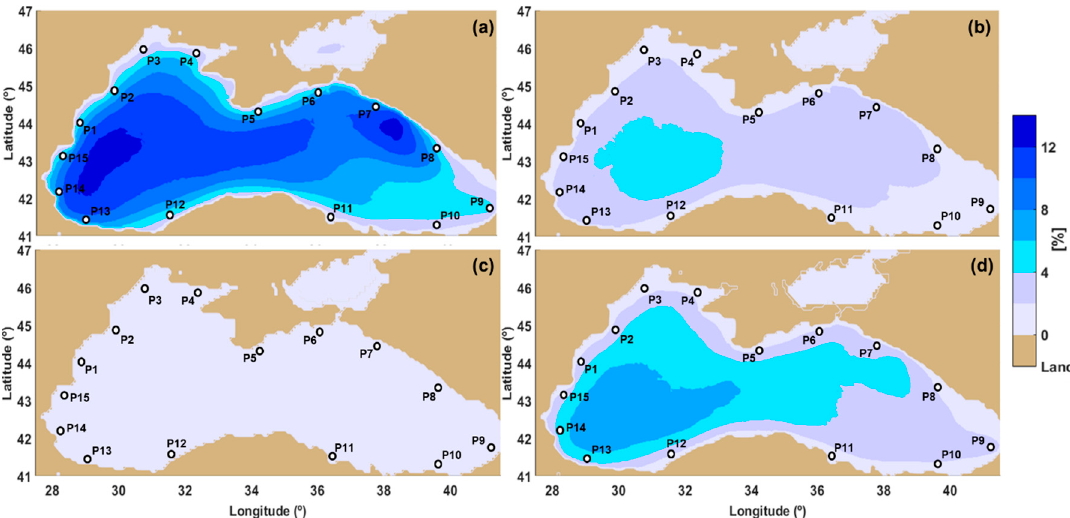
Figure 4. Seasonal distribution of the Hs parameter higher than 2.5 m considering the entire 30-year SWAN simulations (1987–2016), where: ( a ) winter; ( b ) spring; ( c ) summer; ( d ) autumn.